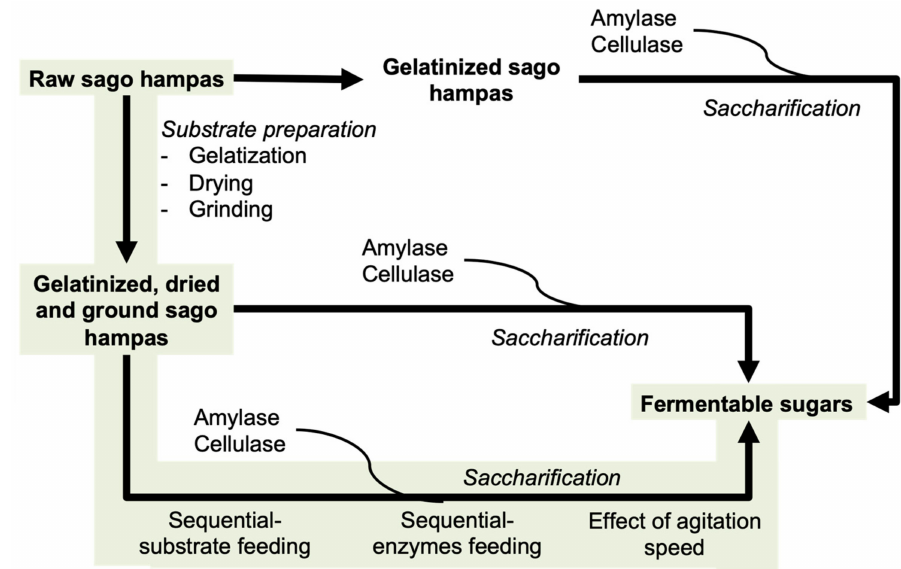
Figure 1. Schematic diagram of experimental work for enzymatic saccharification of sago